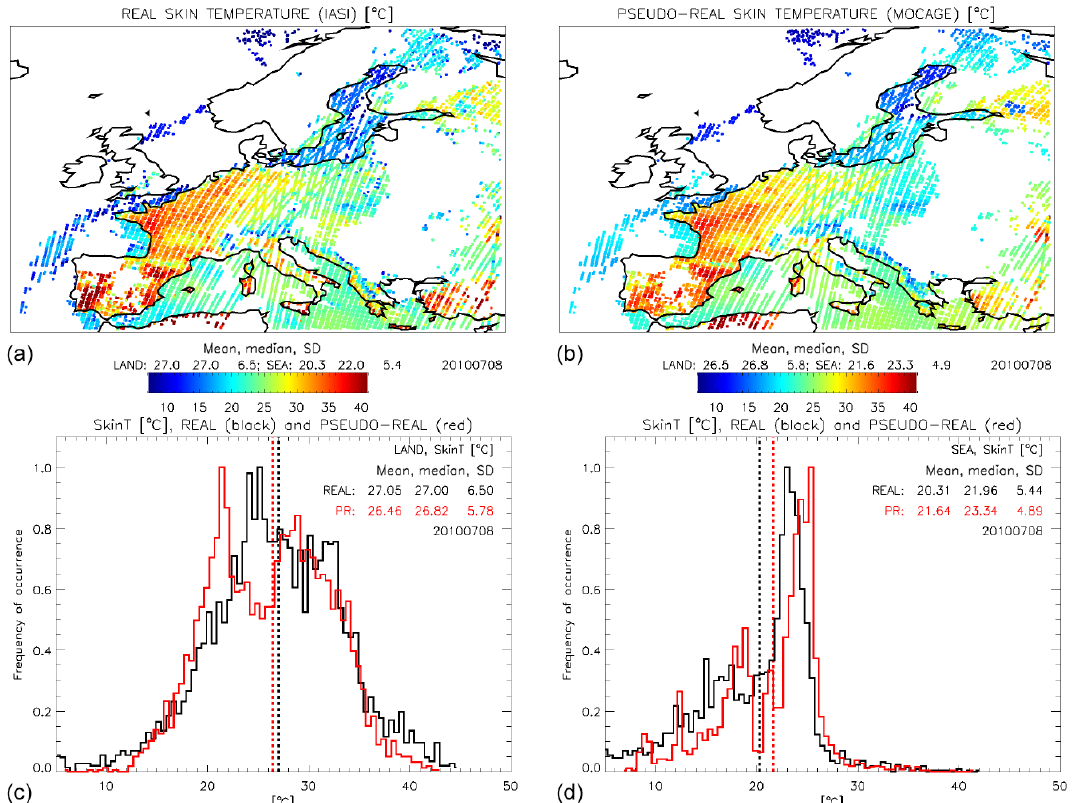
Figure 3. Maps of surface temperature, T s [ ◦ C], from real IASI measurements (a) and from the MOCAGE simulation (b) before correction, for 8 July 2010. For consistency with IASI data, we consider only those MOCAGE pixels that would have been selected by IASI + GOME-2 retrieval algorithm on that day. Histograms of T s normalized frequency distributions from real data (IASI, black) and pseudo-real outputs (MOCAGE, red) over land (c) and ocean (d) . Dashed lines indicate the mean value. We consider only those pixels with skin temperature in the 5–45 ◦ C range and where the absolute T s difference between real measurements and MOCAGE is lower than 10 ◦